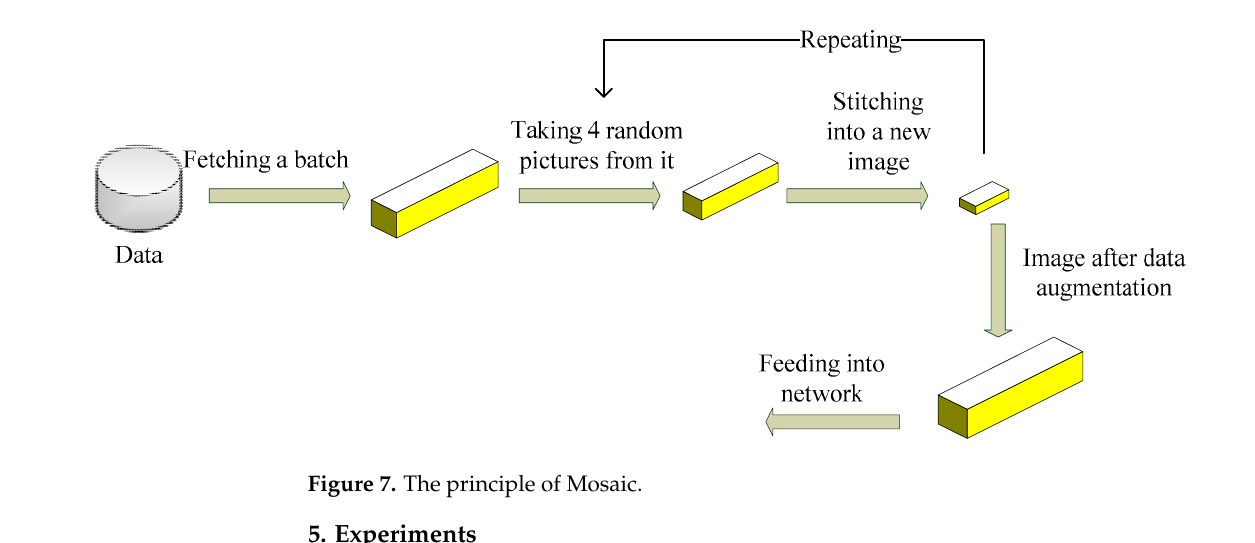
Figure 7. The principle of Mosaic .